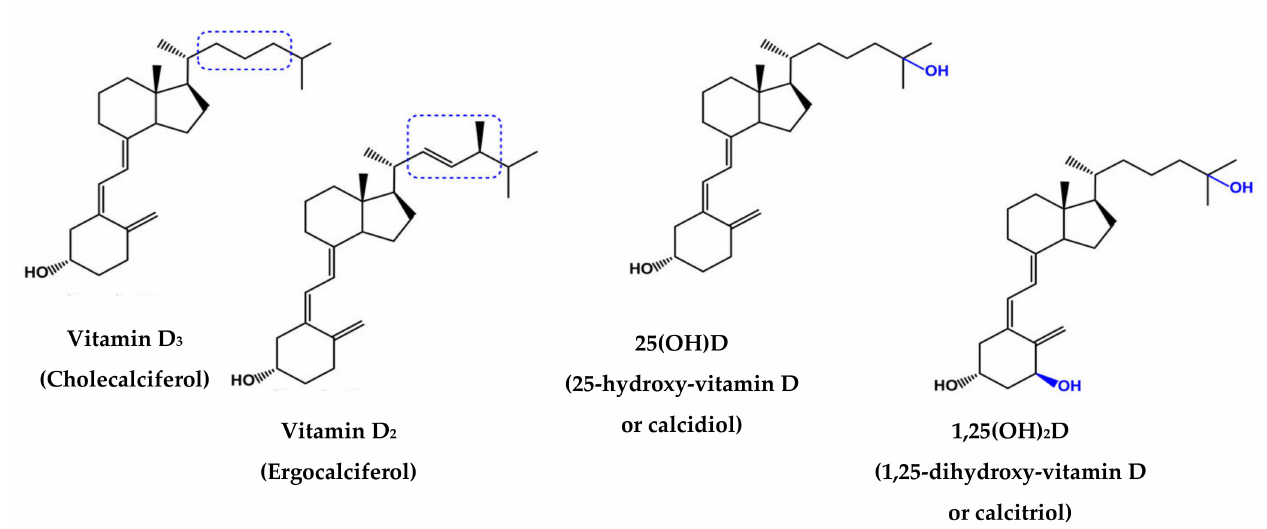
Figure 1. Chemical structures of vitamins D3, D2, 25(OH)D and 1,25(OH) 2 D. Structural differences are highlighted in blue. Adapted from